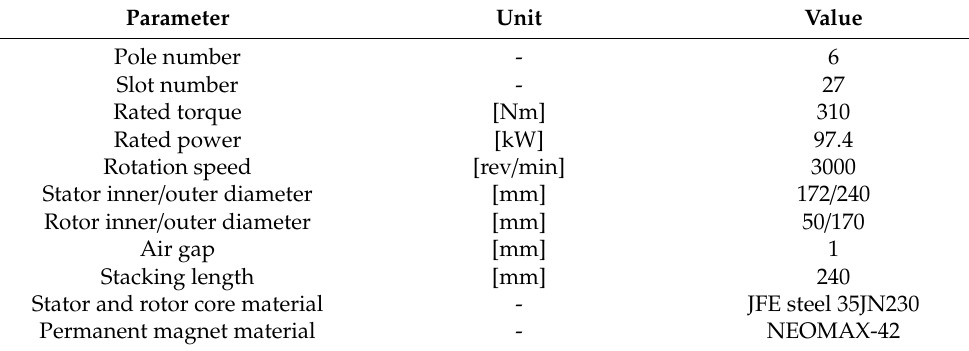
Figure 7. One-third of the periodic analysis model of basic model and design variables. Table 3. Specifications and requirements of an objective motor.